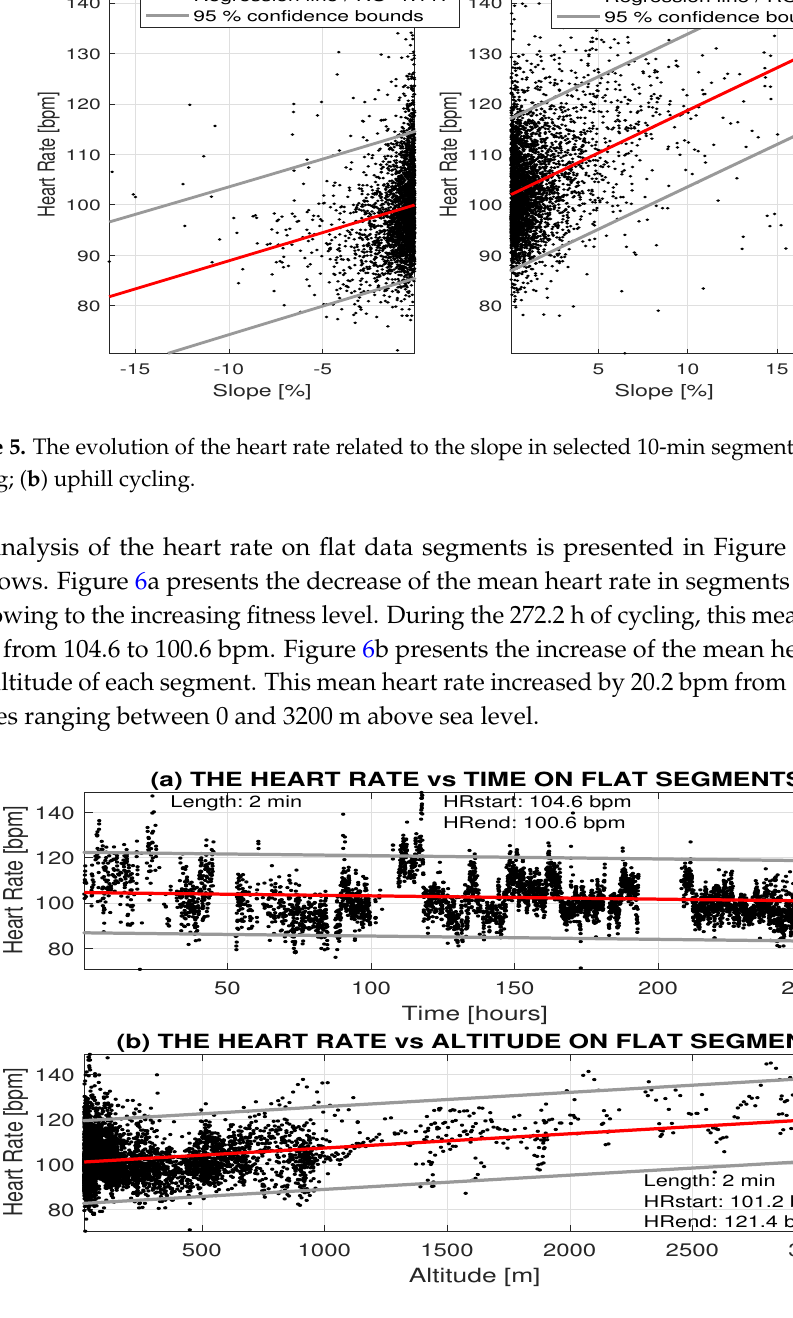
Figure 6. The evolution of the heart rate related to time in selected flat two-minute segments: ( a ) decrease of the heart rate in segments below an altitude of 800 m owing to the increasing fitness; ( b ) the increase of the mean heart rate related to